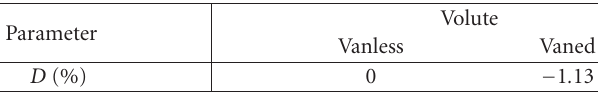
Table 4: Unsteadiness degree of